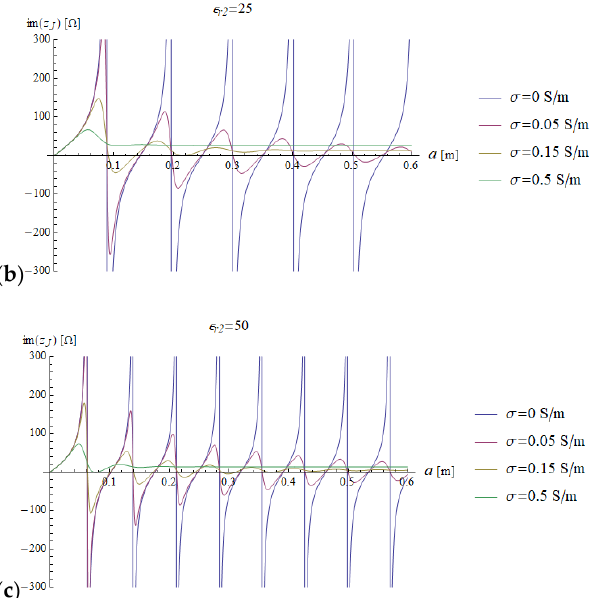
Figure 5. The imaginary part of the sphere impedance is plotted as a function of the sphere radius for different values of relative permittivity ( ε r 2 = 5, 25 and 50 in ( a – c ), respectively) and a range of conductivity values.